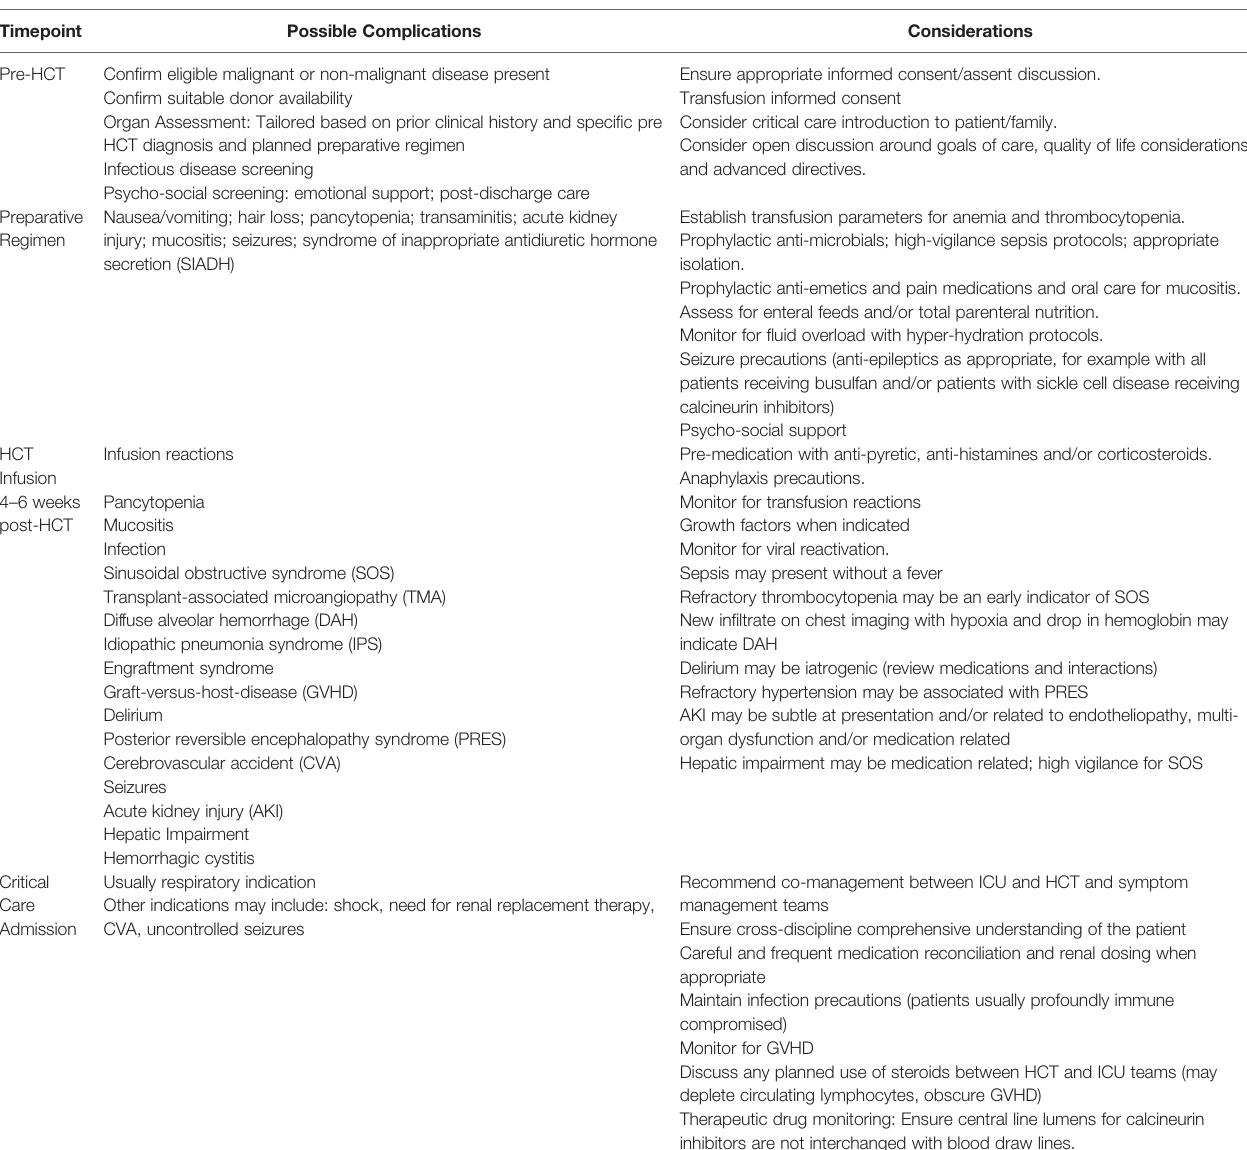
TABLE 1 | Transplant Associated Complications and Considerations. Timepoint Possible